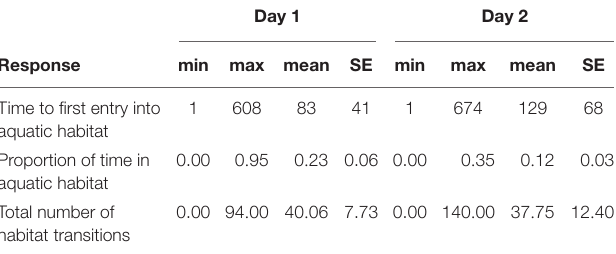
TABLE 3 | Factors influencing newt habitat use on Day